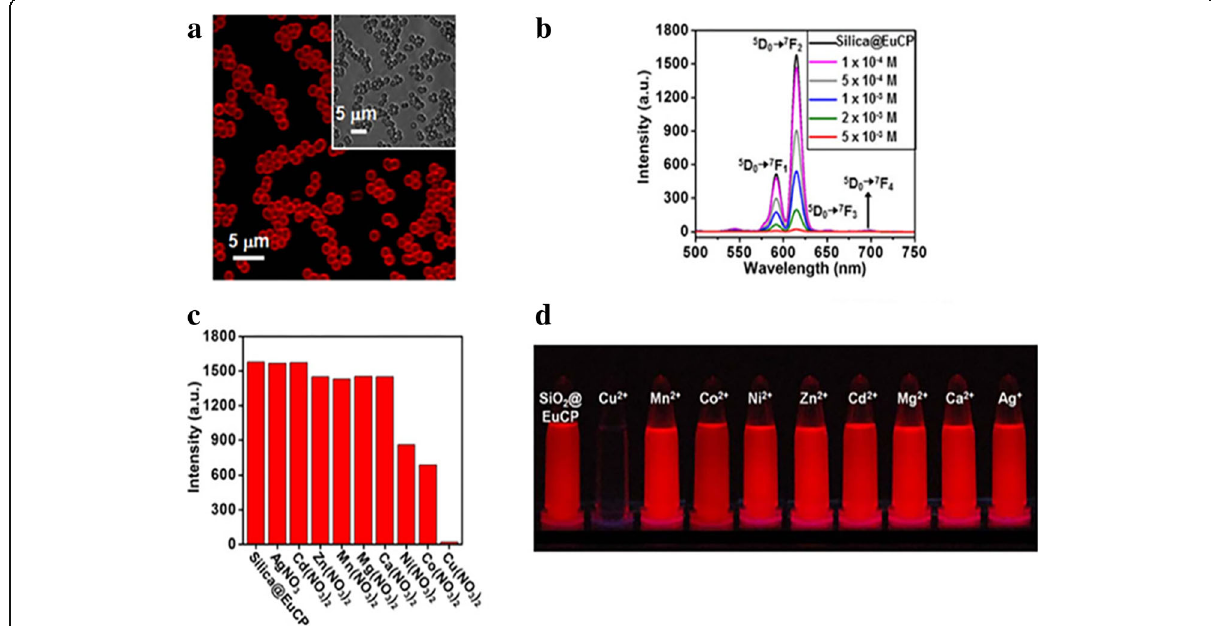
Fig. 19 a Confocal microscopy and OM (inset) images of silica@EuCP microspheres. b Luminescence spectra with different Cu (NO 3 ) 2 in MeCN; luminescence intensity changes ( c ) and photograph ( d ) with different metal ion solutions (5 mM)